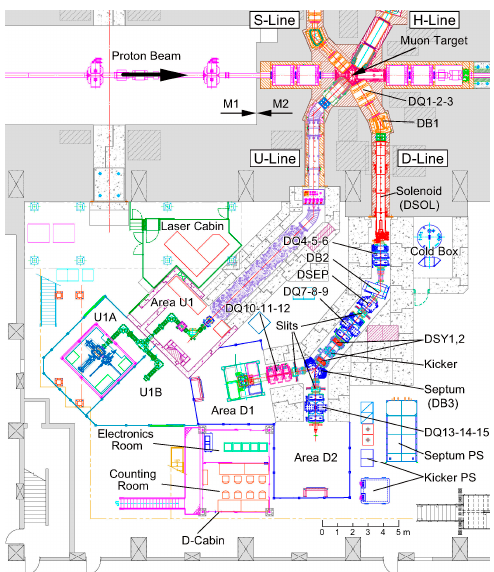
Figure 7. Layout of the D-line in MLF experimental hall No. 2. The key components are the superconducting decay solenoid that brings muons from the proton beam tunnel into the experimental hall, the kicker system that separates the double-pulsed muon beam, and the septum magnet that delivers muons to areas D1 and D2.